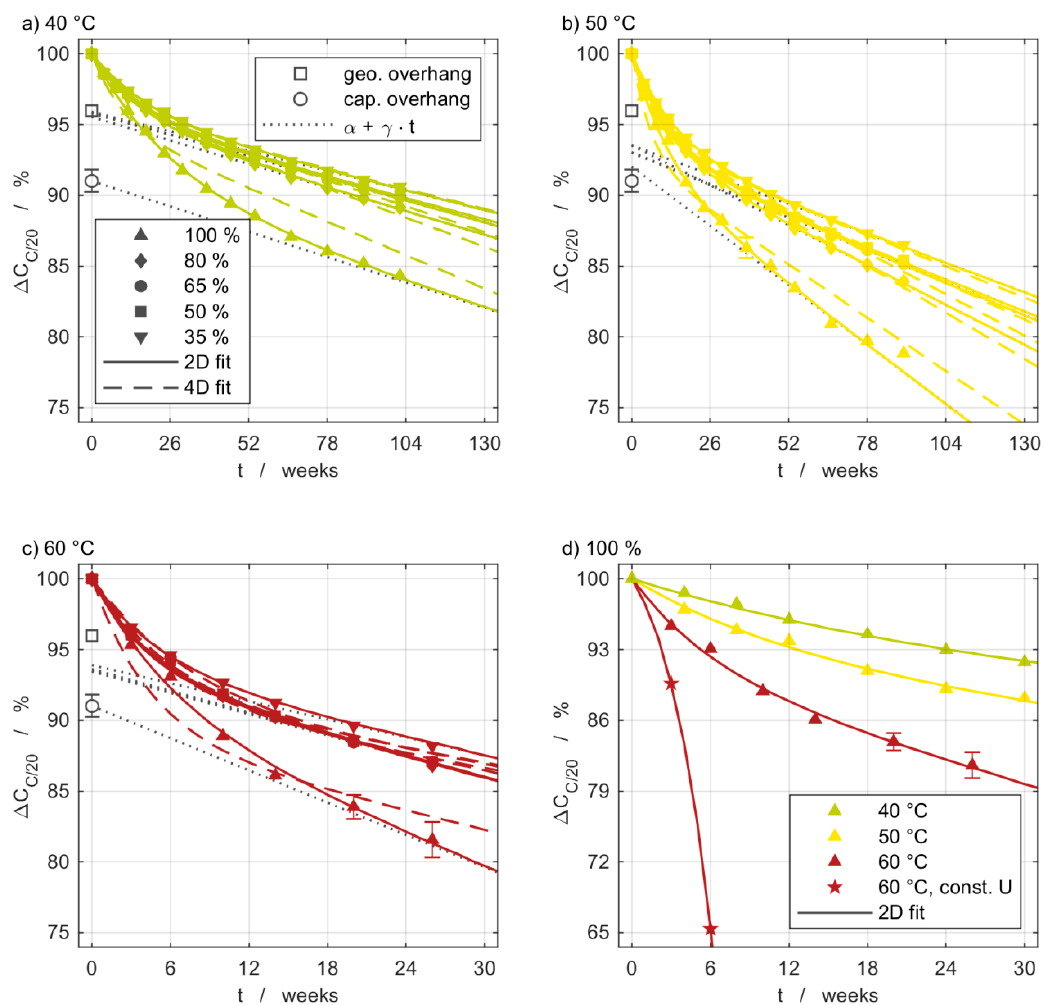
Figure 4. Discharge capacity fade for different SoC at the three temperatures of ( a ) 40 ◦ C, ( b ) 50 ◦ C and ( c ) 60 ◦ C. The comparison between OC and CV storage at 100% SoC and 60 ◦ C is shown in ( d ). The markers indicate intermediate cell characterizations, and the models are shown as lines. The dotted lines show the linear parts of the 2D fits compared to the anode overhang area and anode overhang capacity. Based on the initial values in Table 1, a capacity fade of 5% corresponds to a loss of approximately 152 mAh.